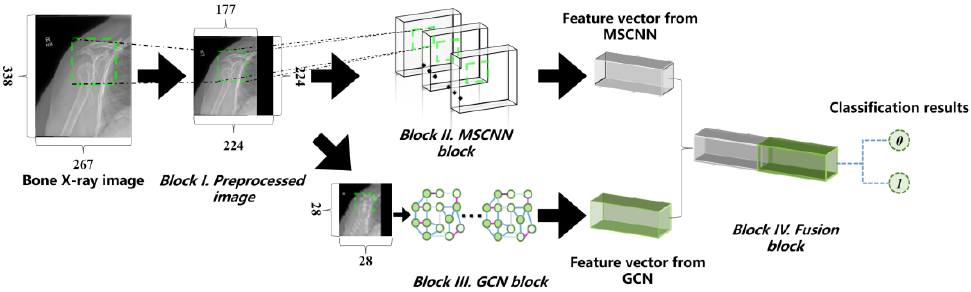
Figure 3. The proposed architecture consists of four blocks. Block I shows the preprocessing procedure for the original image. Block II shows a multi-scale convolution neural network (MSCNN) block, consisting of three branches, which obtains more detailed information from the preprocessed image. Block III shows a graph convolution network (GCN) block to extract global structure information from the downsampled image. Block IV shows a fusion block to demonstrate the classification results through the concat of the two feature vectors from MSCNN and GCN, respectively.